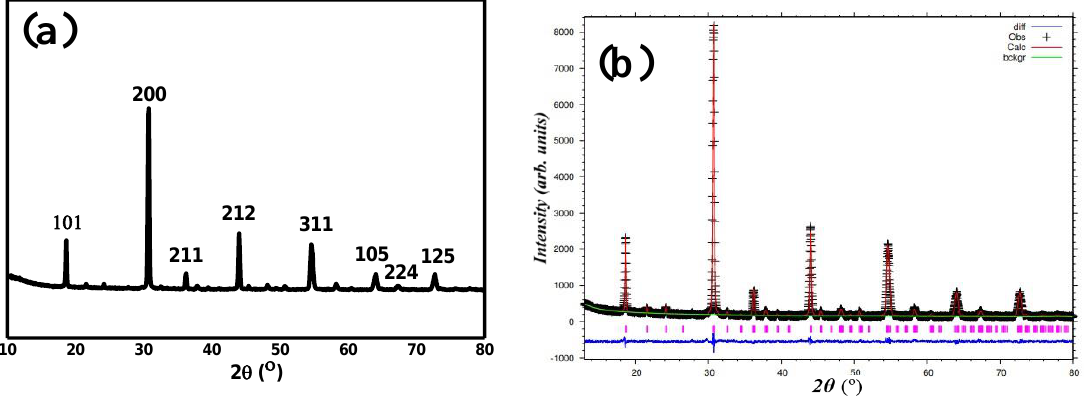
Figure 1. ( a ) XRD graph and ( b ) refinement of XRD data of Sr 2 CaTeO 6 . The black lines, pink lines, and blue lines are the observed patterns, the calculated data, and the difference, respectively.